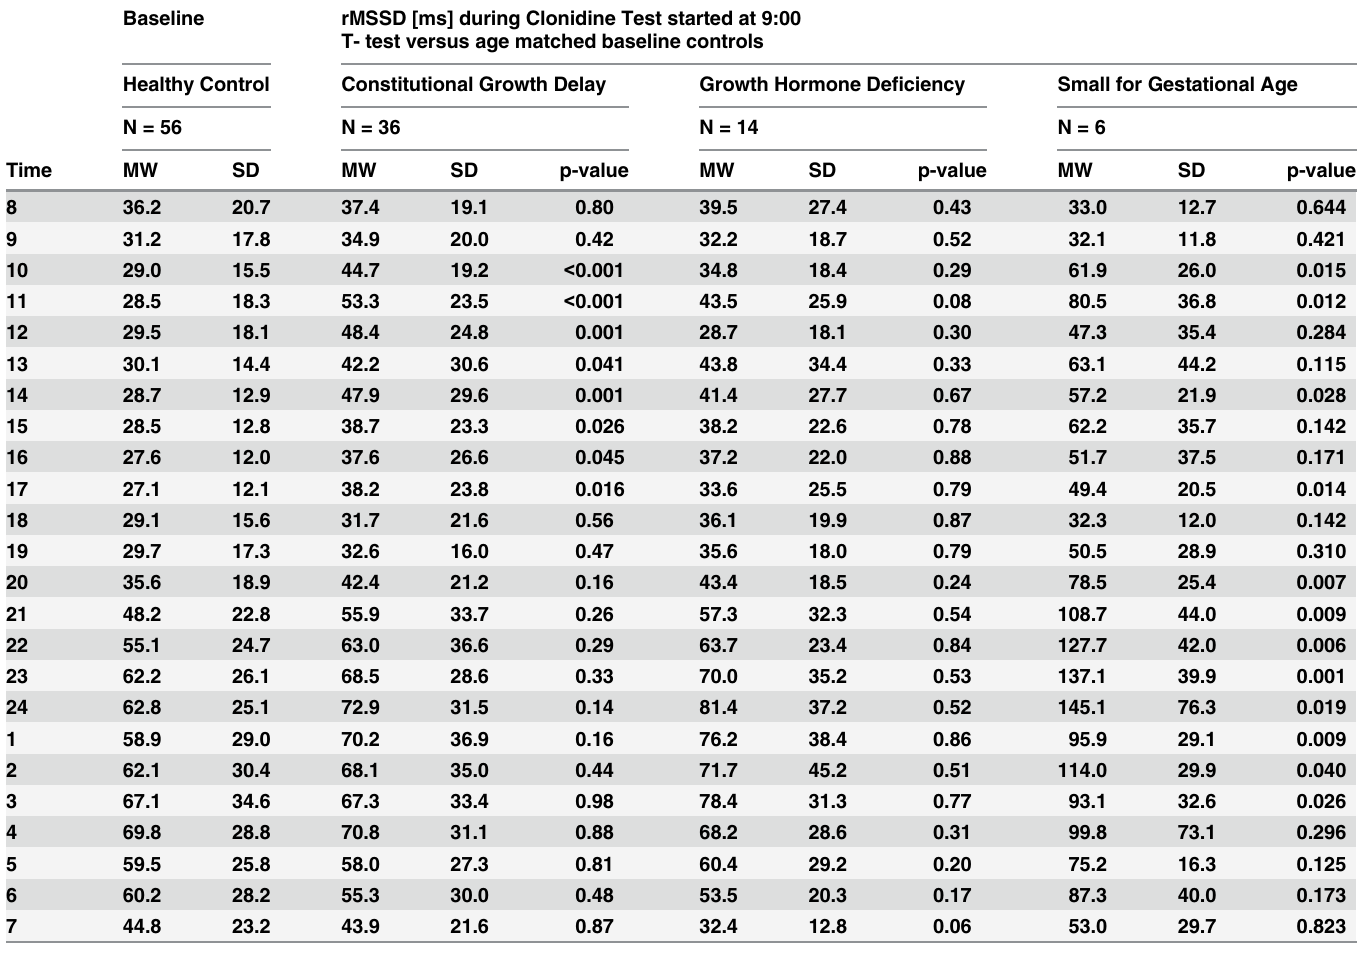
Table 3. rMSSD values during clonidine testing and healthy